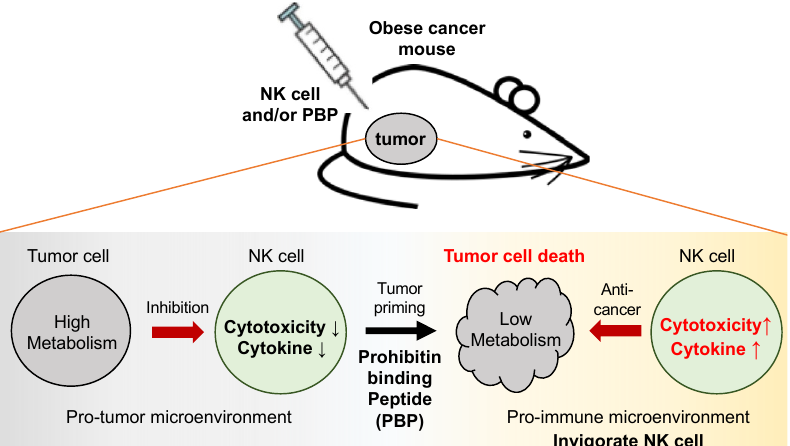
Figure 7. Schematic illustration. The tumors of obese cancer mice are directly injected with NK cells with or without treatment with prohibitin binding peptide (PBP). PBP priming inhibits glucose metabolism in cancer cells and reduces the production of metabolites, leading to changes in the tumor microenvironment rendering it more supportive of functional immune cells. Finally, NK cells regain cytotoxic activity, inhibiting tumor growth more efficiently in PBP-primed cancers in obese mice. PBP-priming of the tumor increased cytokine secretion by NK cells (Figure 5), in- creasing their cytolytic anti-cancer activity, which was substantiated by two measures of tumor growth (Figure 4). Evidence that both manifestations of PBP-tumor priming were the consequence of restoring function to NK cells was sought by flow cytometry of NK cells extracted from the tumors. Normally, CD56 dim and CD16-positivity are emblematic of strong effector NK cells while CD56 bright and CD16-negative NK cells are characteristically weakly cytotoxic [39–41]. Recent data, however, indicate that CD56 dim and CD16-negative NK cells exert moderate cytotoxic activity that is nonetheless greater than that found with CD56 bright and CD16-positive/-negative NK cells [39,42]. This finding emphasizes that CD56 dim is the determinative marker of effector function of NK cells. Moreover, the frequency of CD56 dim NK-92 cells had a positive correlation with cytotoxicity and cytokine secretion when exposed to breast cancer cells [43]. The NK-92 cells used in our study were initially either CD16-negative or -low; subsequently, CD16 expression levels were not different between PBP-primed and PBP non-primed groups (data not shown). Because NK cells showing CD56 dim regardless of CD16 status have strong cytotoxic activity, we gated cells into CD56 dim and CD56 bright subsets for comparison with their cytolytic activities. We found that the CD56 dim NK cell population was larger in PBP-primed tumors than in tumors not primed. This population—representing strong cytolytic activity—is critical to the enhanced anti-cancer activity of NK cells because of their increased cytokine release.